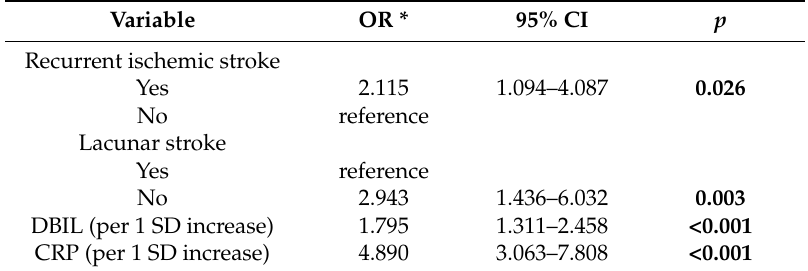
Table 4. Multivariate logistic regression analysis of significant risk factors for outcome at discharge in acute ischemic stroke